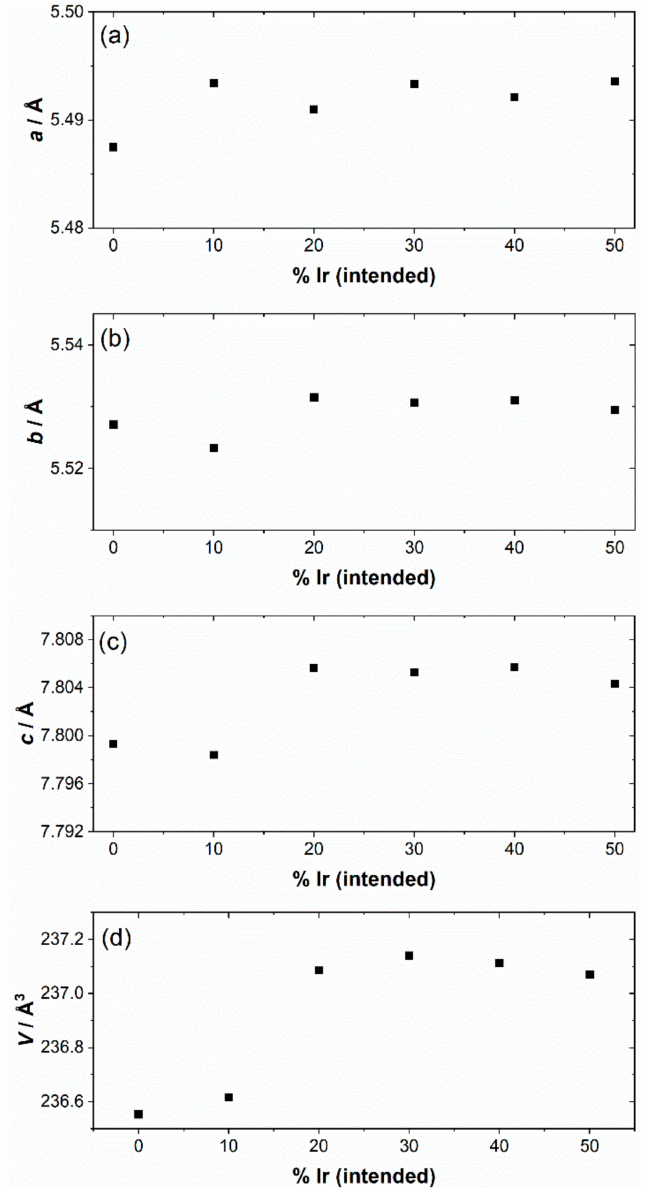
Figure 2. Variation of lattice parameters of Ir-NaTaO 3 materials with intended composition. ( a ) a , ( b ) b , ( c ) c , and ( d ) unit cell volume. The error bars are smaller than the data